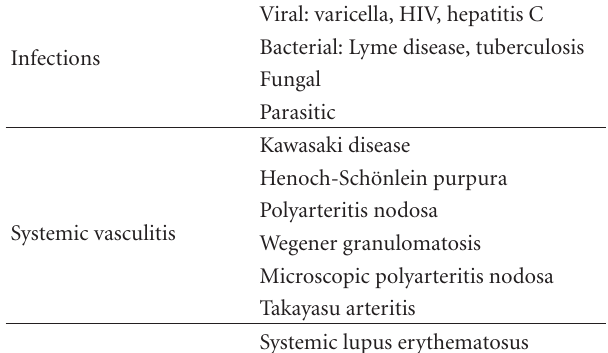
Table 1: Causes of secondary central nervous system vasculitis in children